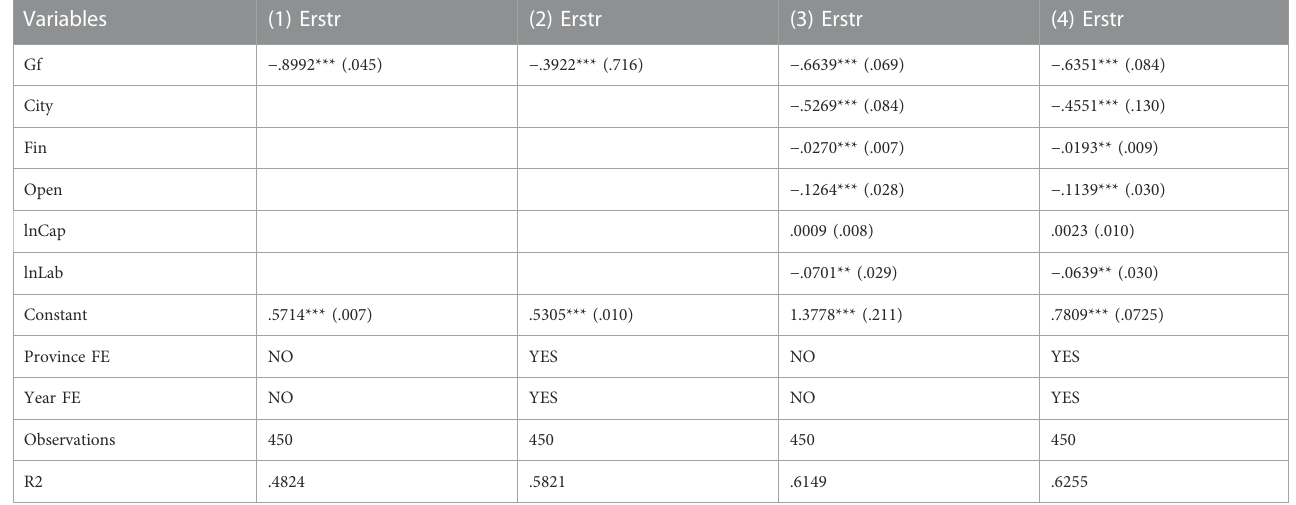
TABLE 4 Baseline regression